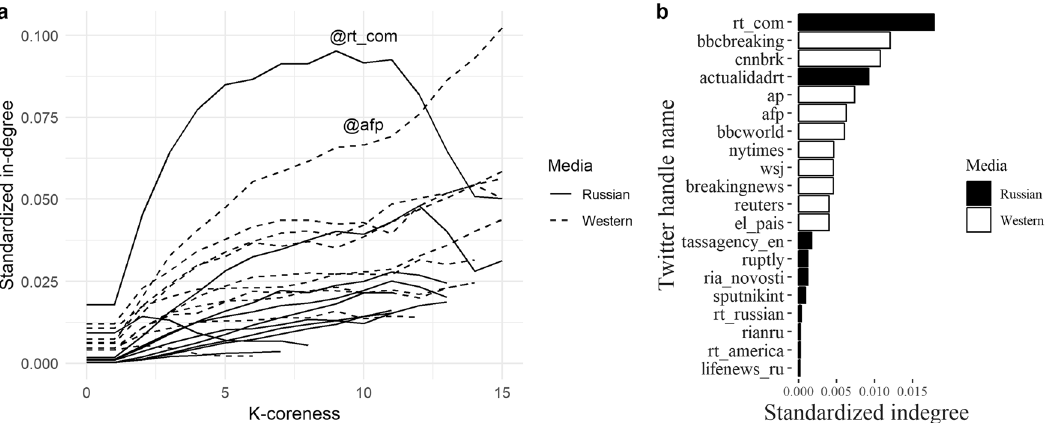
Fig. 4 The impact of top 10 Russian and Western news outlets. a Standardized ind-degree for the individual outlets in the core/periphery and b in the entire retweet network ( k =